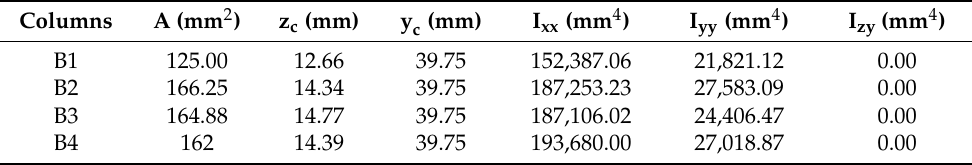
Table 3. Geometric characteristics of cross-sections